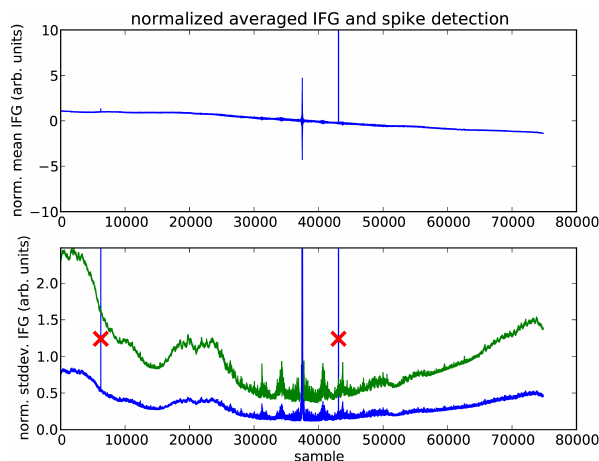
Figure 10. Normalised mean (top) and standard deviation (bottom) of a raw interferogram of an atmospheric measurement. The green curve shows three times the standard deviation. The red crosses mark identified